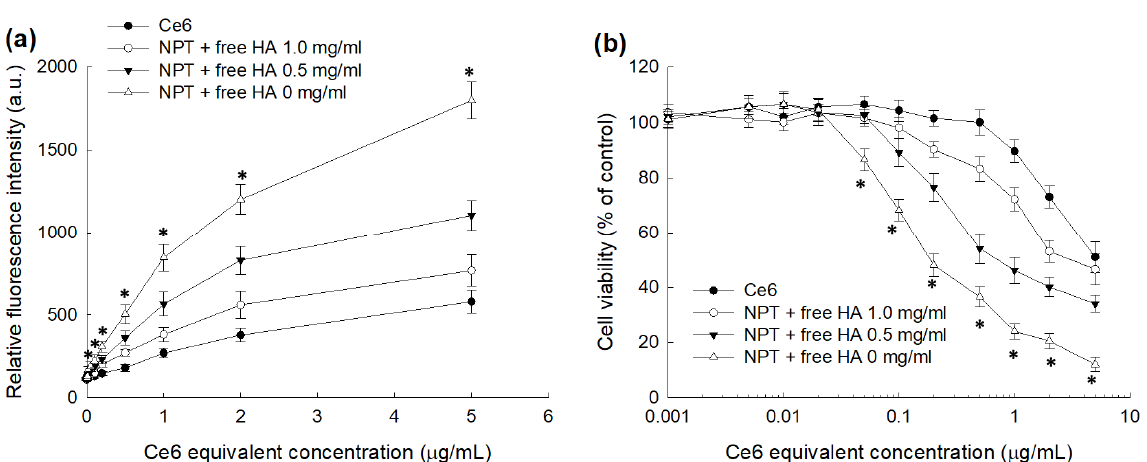
Figure 7. The effect of HAthCe6 nanophotosensitizers against HeLa cells. Free Ce6 or nanophoto ‐ sensitizers in serum ‐ free media were treated to 2 × 10 4 cells/well in 96 well plates and then irradiated at a light dose of 2 J/cm 2 . ( a ) ROS generation. A DCFH ‐ DA assay was used to evaluate intracellular ROS level. For control treatment, serum ‐ free media were used. ( b ) PDT efficacy. Cell viability was evaluated by MTT assay. * indicates statistical significance when the group of (NPT + free HA, 0 mg/mL) was compared to the group of Ce6 (ANOVA followed by Tukey’s test, p < 0.05).